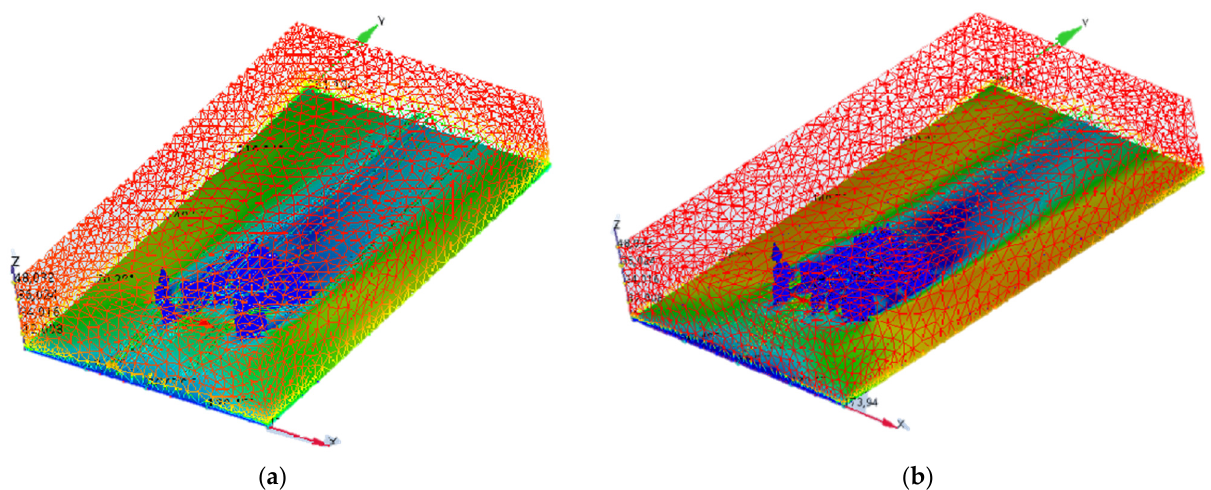
Figure 14. Grid discretization of the computational domain. ( a ) Grid of the basic urban model, ( b ) Grid of the urban model with modular buildings.